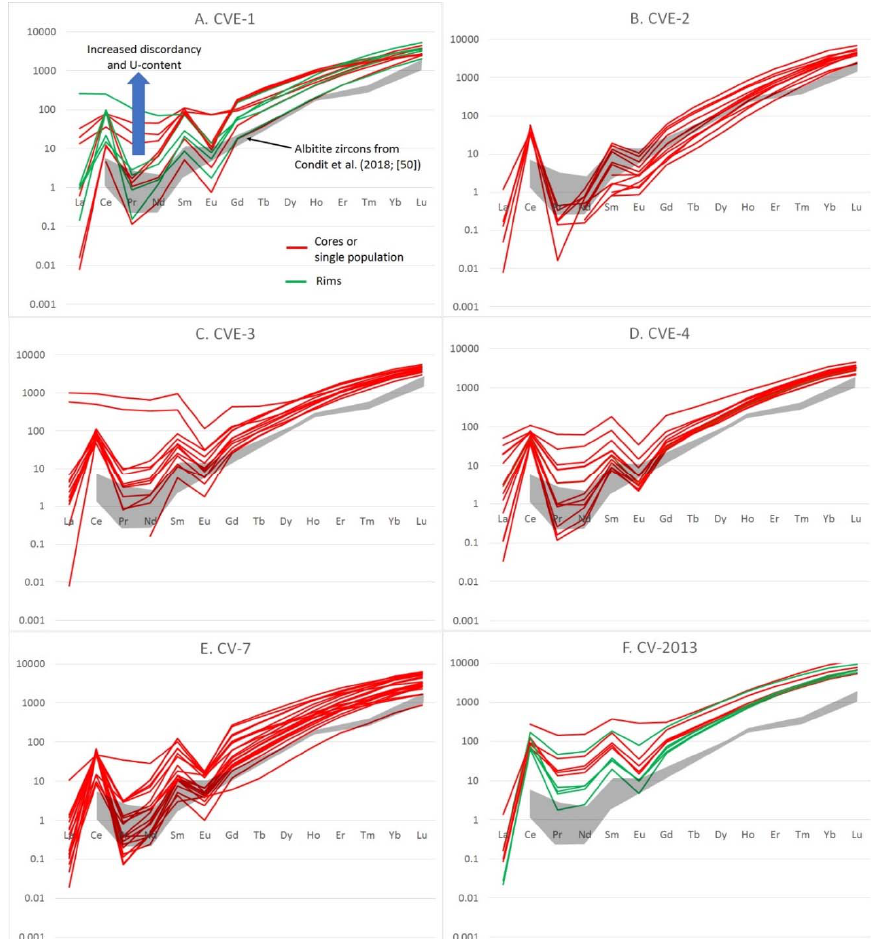
Figure 8. Chondrite-normalized rare earth element diagrams for the samples analyzed in this study. ( A ) CVE-1, ( B ) CVE-2, ( C ) CVE-3, ( D ) CVE-4, ( E ) CV-7, and ( F ) CV-2013. Thick black line shows average values from Table 3. Red lines indicate analyses from the center of homogeneous grain populations or older populations of grains interpreted as xenocrysts. The green lines are from rims when cores and rims could be readily distinguished. Grey shading represents zircons from albitites from the Big Sky Orogen (Condit et al., 2018 [48]). Table 3. Average rare earth element concentrations measured in zircon from rock samples of the Cheever Mine, New York. Concentrations are normalized to chondritic values [47].